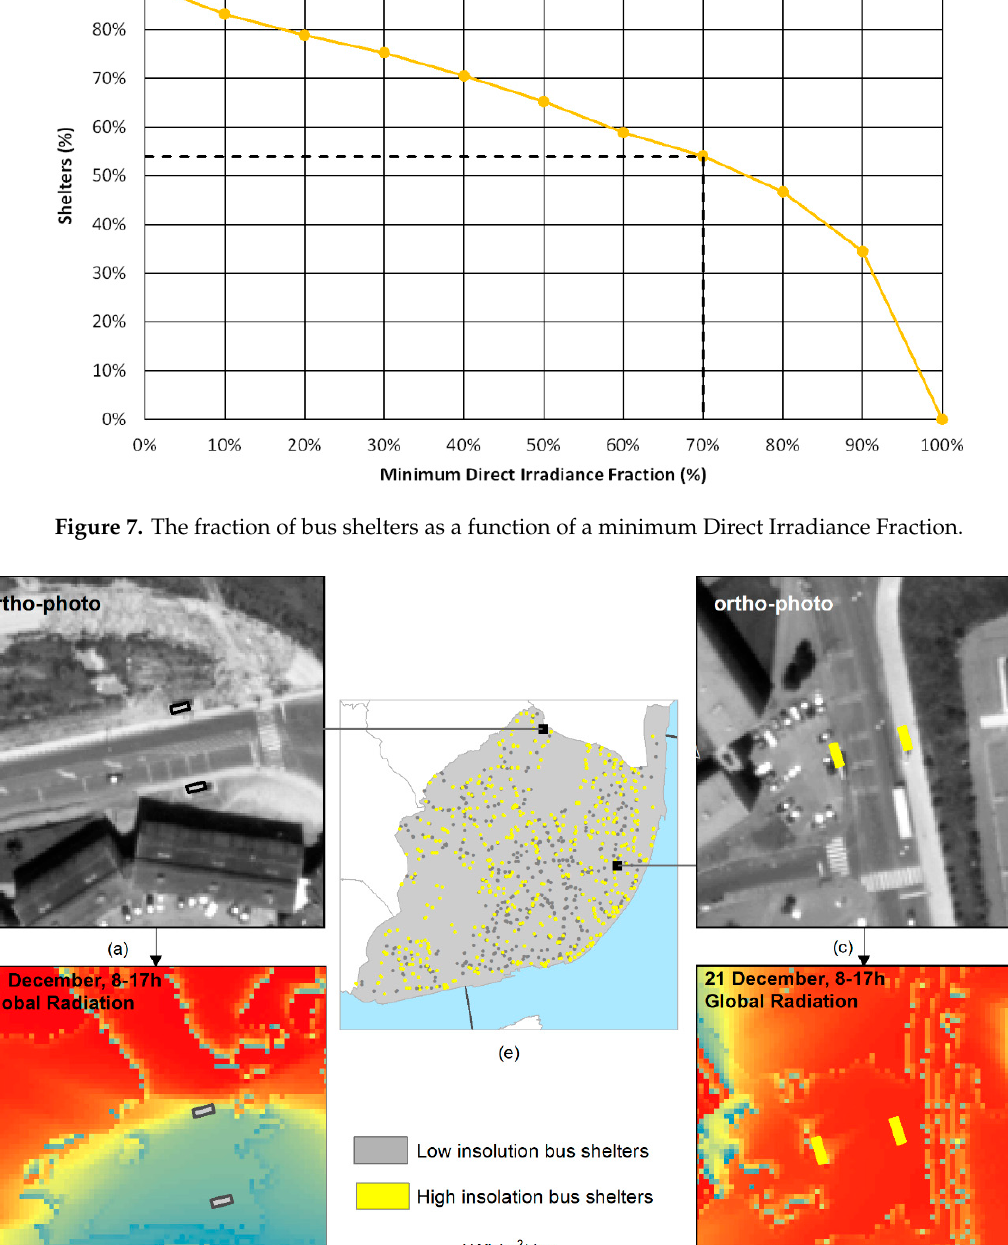
Figure 8. Low ( a , b ) and high ( c , d ) insolation bus shelters’ spatial distribution in Lisbon ( e ).